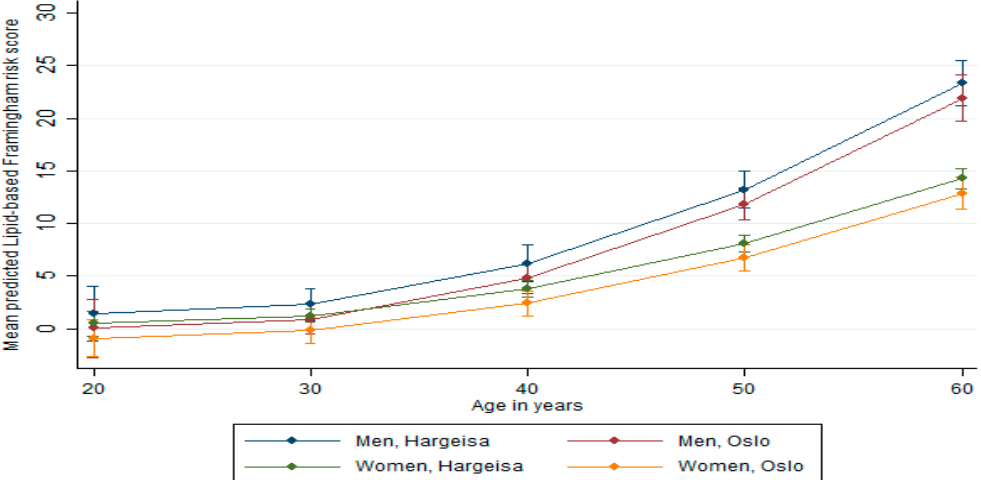
Figure 1. Lipid-based Framingham risk score by age, gender, and location (vertical lines are means with 95% confidence intervals).